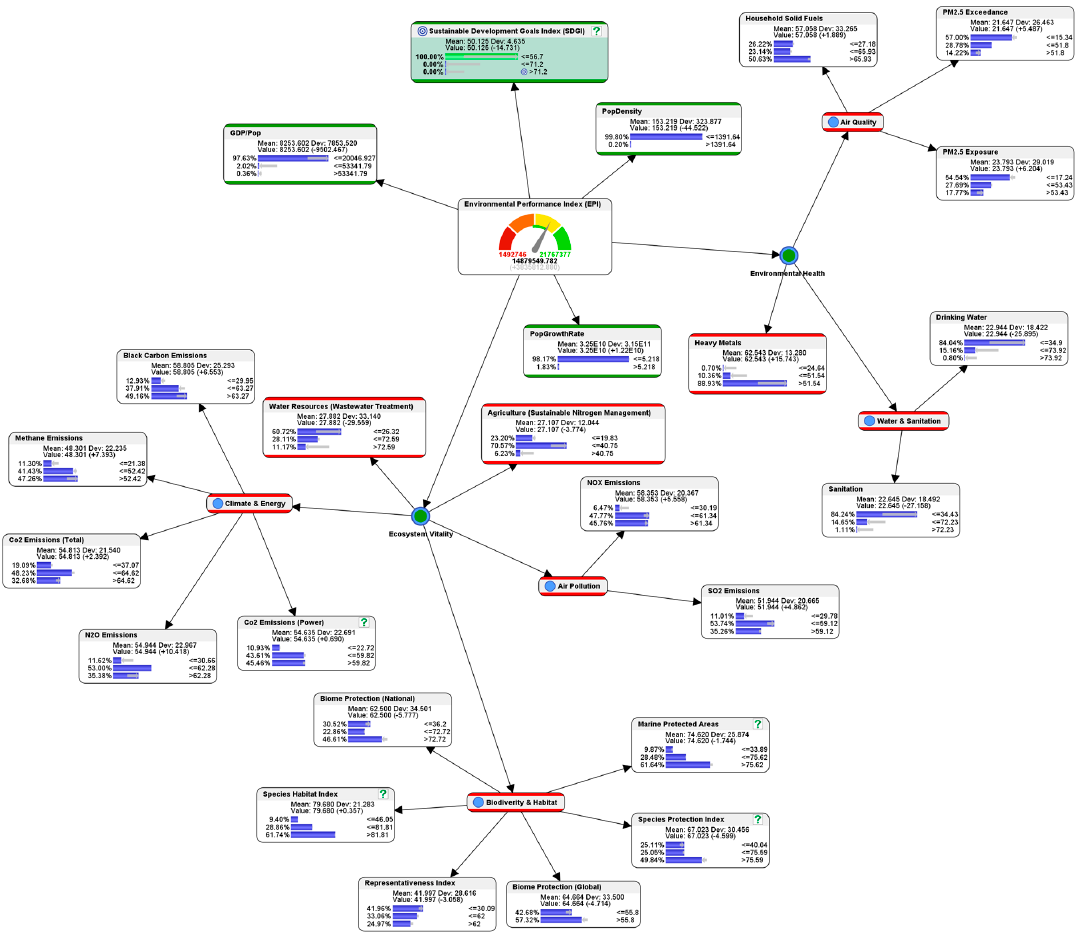
Figure 7. Example of a worst-case scenario. Table 4. Results of predictive analysis of the worst-case scenario.